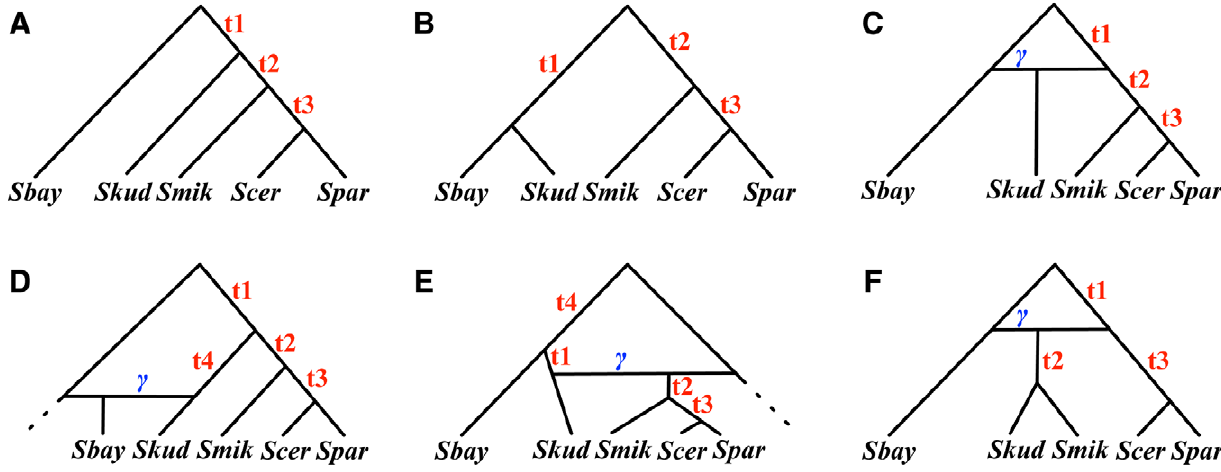
Figure 2. Various hypotheses for the evolutionary history of a yeast data set. (A) The species tree for the five species Sbay , Skud , Smik , Scer , and Spar , as proposed in [35], and inferred using a Bayesian approach [39] and a parsimony approach [36]. (B) A slightly suboptimal tree for the five species, as identified in [36,39]. (C–E) The three phylogenetic networks that reconcile both trees in (A) and (B), and which we reported as equally optimal evolutionary histories under a parsimony criterion in [30]. (F) A phylogenetic network that postulates Smik and Skud as two sister taxa whose divergence followed a hybridization event.